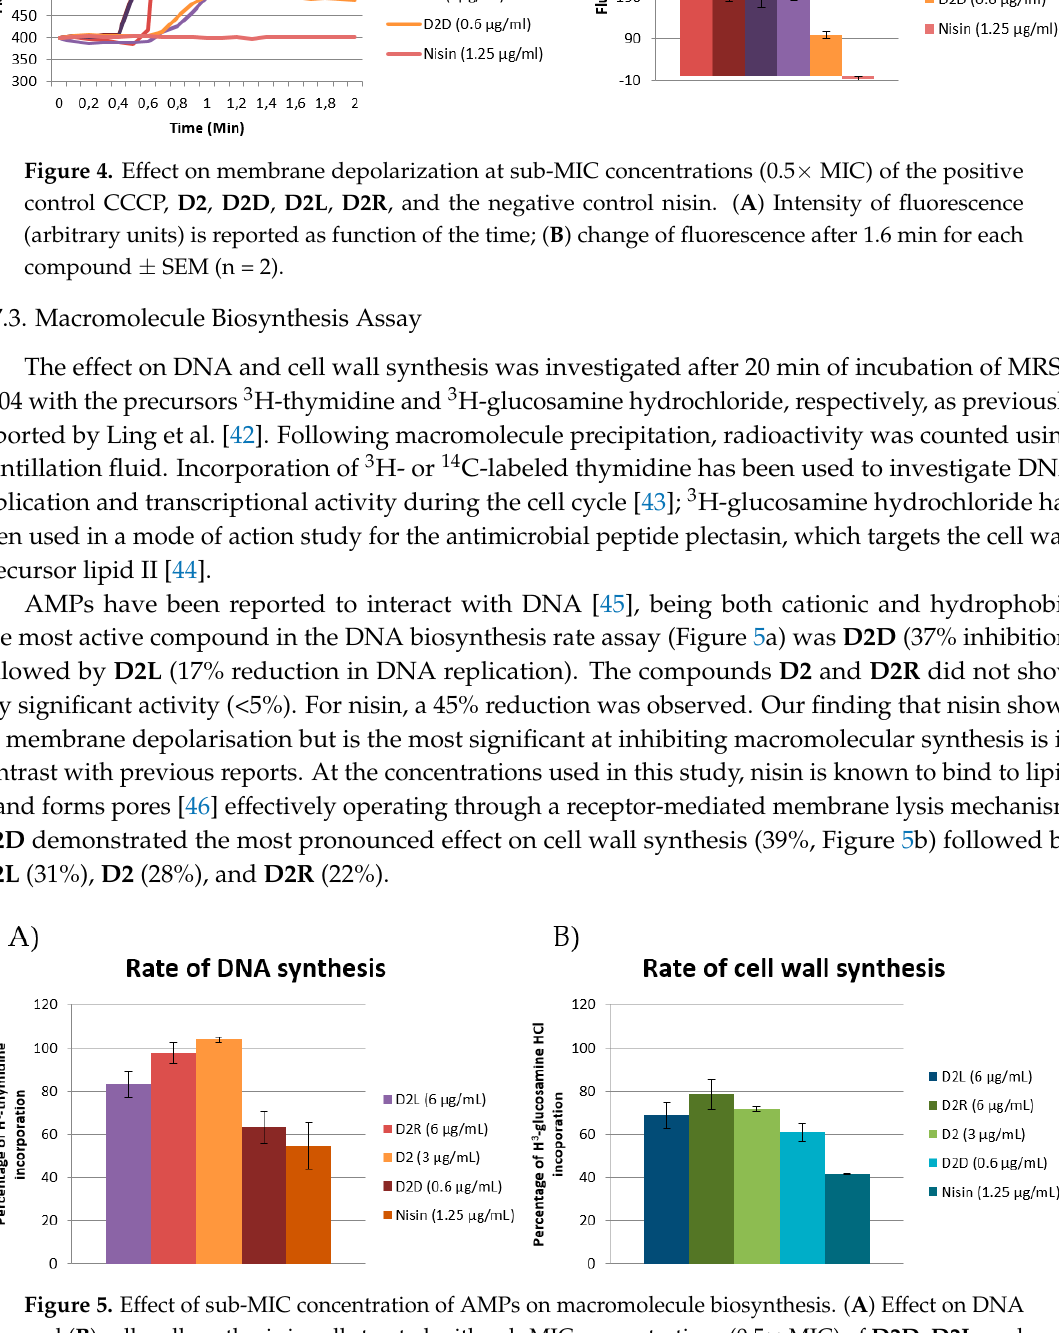
Figure 5. Effect of sub-MIC concentration of AMPs on macromolecule biosynthesis. ( A ) Effect on DNA and ( B ) cell wall synthesis in cells treated with sub-MIC concentrations (0.5 × MIC) of D2D , D2L , and D2R after 20 min of incubation. The peptide nisin was used as control. Data are represented as means of two repeated experiments ± SEM.